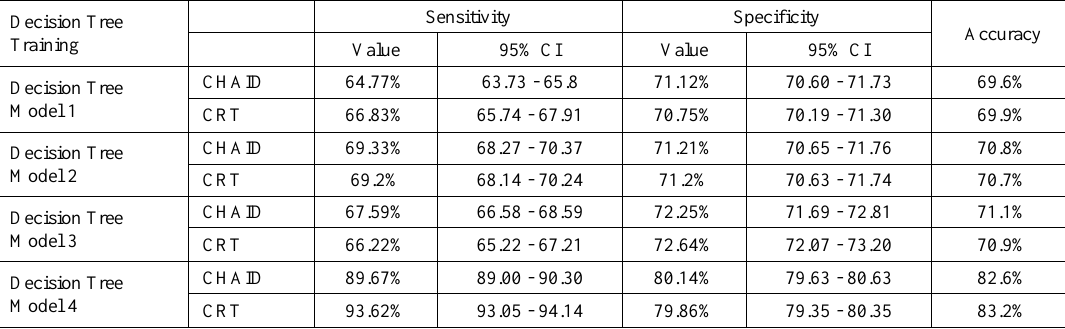
Table 6. Decision trees training results: sensitivity, specificity and